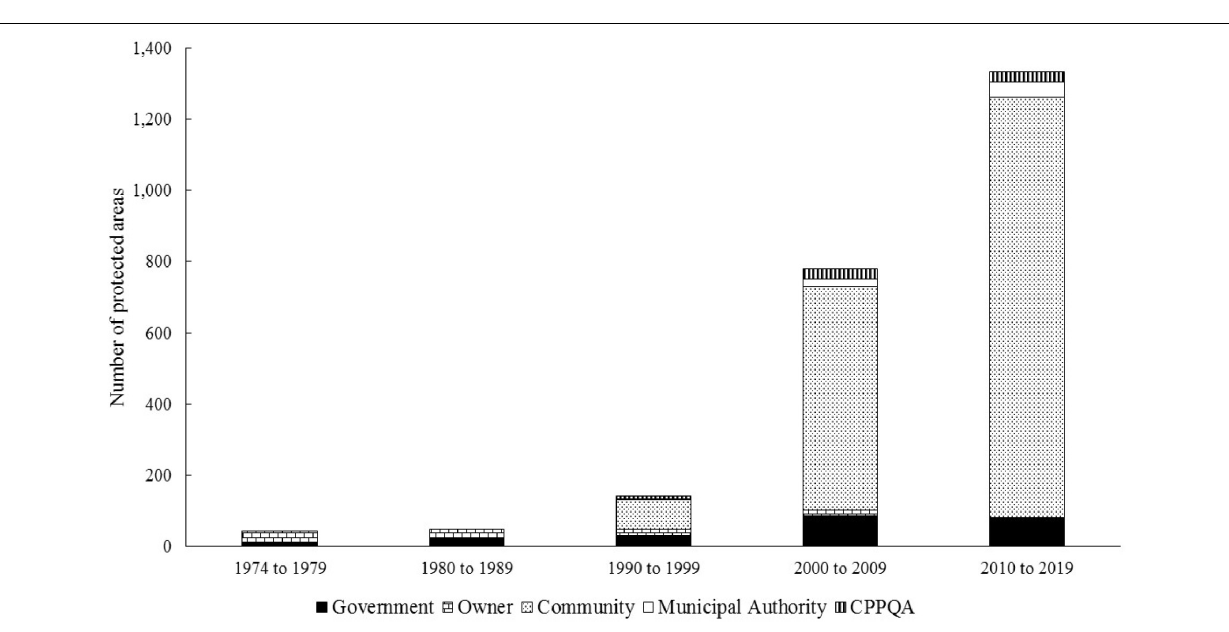
government and 0.9% by the CPPQA. If we consider only the areas of community protection, the Pé-de-pincha program conserved 98.4% of the production of hatchlings of this